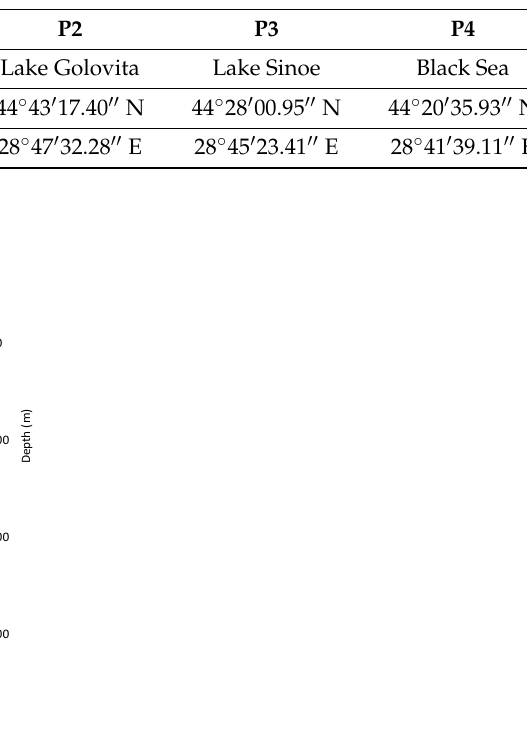
Figure 1. Map of the western side of the Black Sea and the location of the four sites considered.